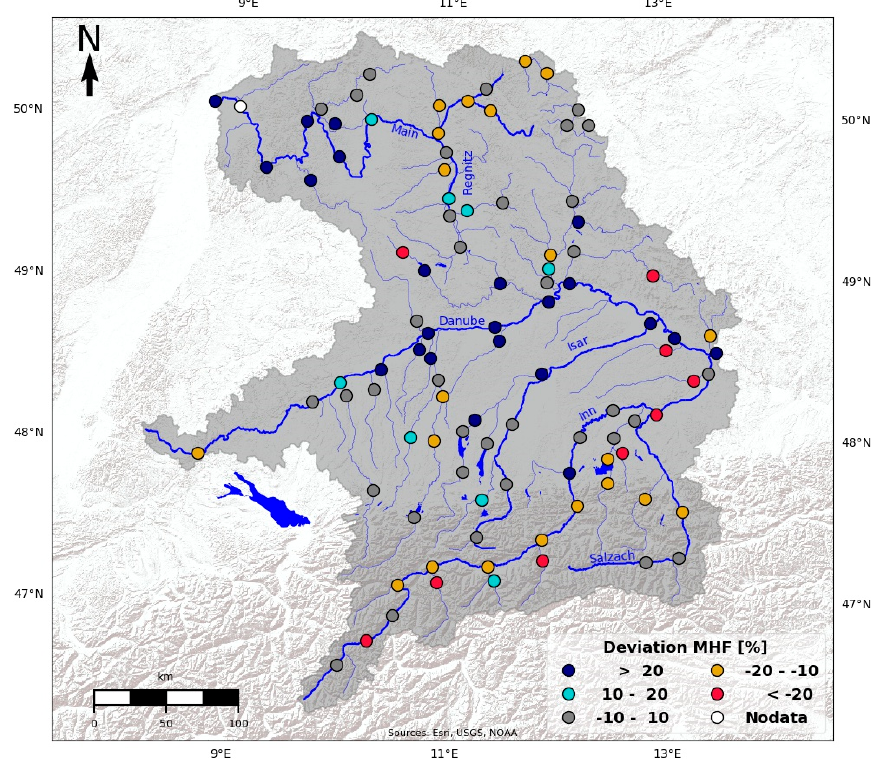
Figure 7. Relative deviations between observed and simulated mean high flows (MHF) for the 98 gauges of the Hydrological Bavaria. gauges of the Hydrological